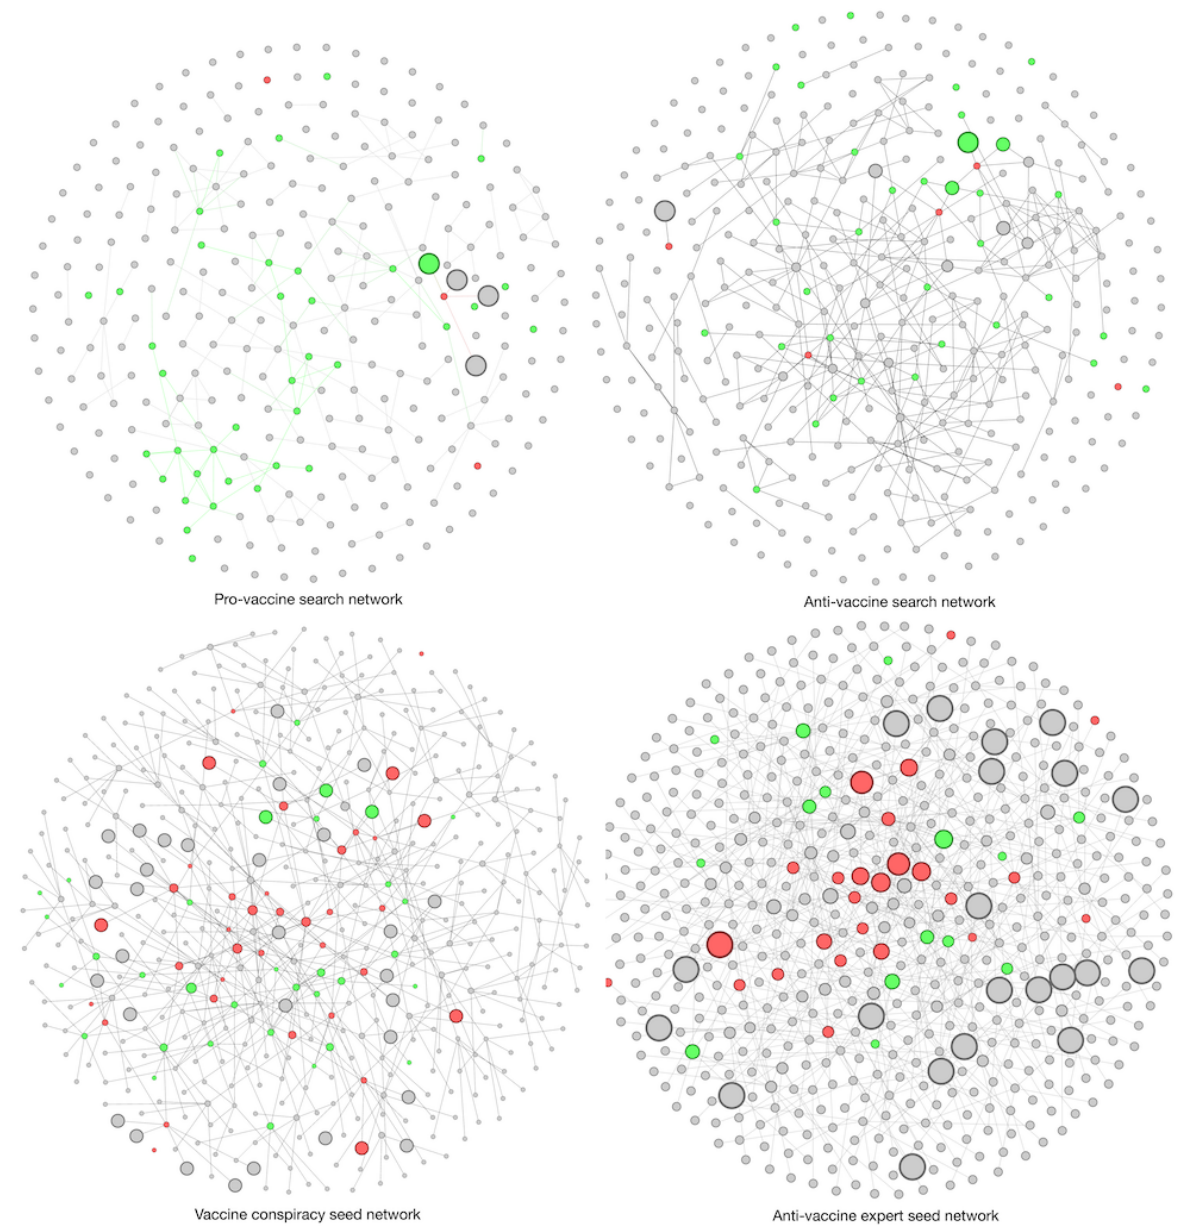
Figure 2. Visualization of the four YouTube video networks, where each node represents a video and an edge represents a related link. Green represents a provaccine video and red represents an antivaccine video. Gray nodes are nonvaccine-related videos. The size of the nodes depicts the exposure value to antivaccination videos. Visualization was generated with